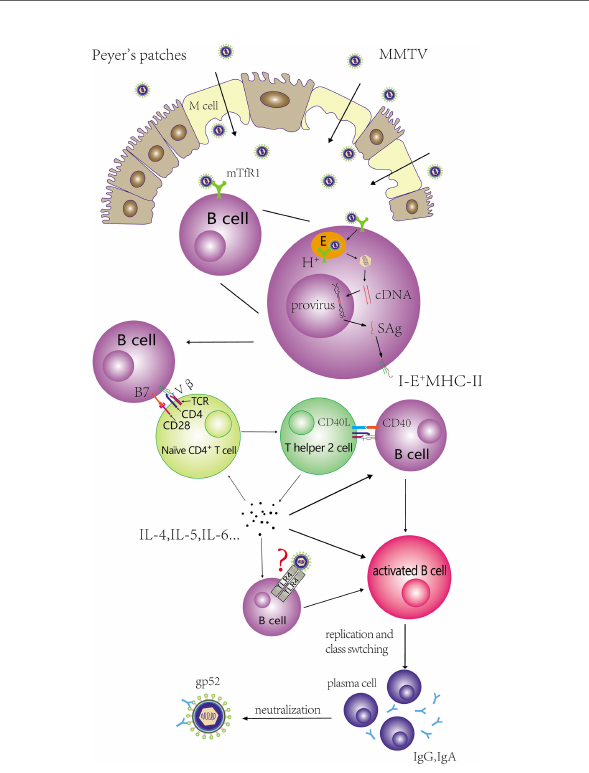
FIGURE 1 | Activation and proliferation of CD4+ T cells and B cells mediated by MMTV. MMTV is transported from intestinal lumen into PPs with the help of M cells, and binds to mTfR1 on B cells. The virus is endocytosed via clathrin-coated pits and the acidic endosomes are traf fi cked to an acidic compartment to induce Env-plasma membrane fusion. MMTV infect these cells and integrate the provirus into the genome of B cells. SAg expressed by MMTV provirus is presented by I-E + MHCII molecules, and binds to the V b domain of TCR. In addition, CD28-B7 interaction also contributes to the activation of naïve CD4 + T cells. The activated CD4 + T cells can differentiate into Th2 cells, and Th2 cells can stimulate extensive B cells. The process involves the interaction of CD40L-CD40. Activated B cells can proliferate and produce antibodies that target MMTV GP52 for